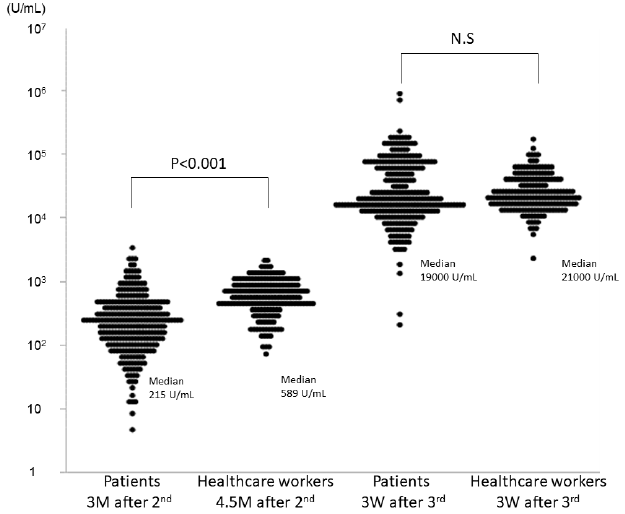
Figure 1. Levels of anti-spike protein immunoglobulin G (IgG) antibody against SARS-CoV-2, 3 months after the second dose of BNT162b2 in patients undergoing hemodialysis and 4.5 months after the second dose of BNT162b2 in the healthcare workers. Levels of IgG antibodies 3 weeks after the third dose of BNT162b2 are shown in both groups. The third dose was administered to both groups approximately 7 months after the second dose. There was no significant difference in anti-S IgG antibody levels between the patients undergoing HD (19,000 U/mL (IQR: 12,000–61,000)_ and healthcare workers (21,000 U/mL (IQR: 15,000–36,500)) (Table 2). All participants showed an increase in their anti-S IgG antibodies to suitable levels (>80 U/mL). The lowest anti-S IgG antibody levels were 206 U/mL and 2280 U/mL in patients undergoing HD and healthcare workers, re-